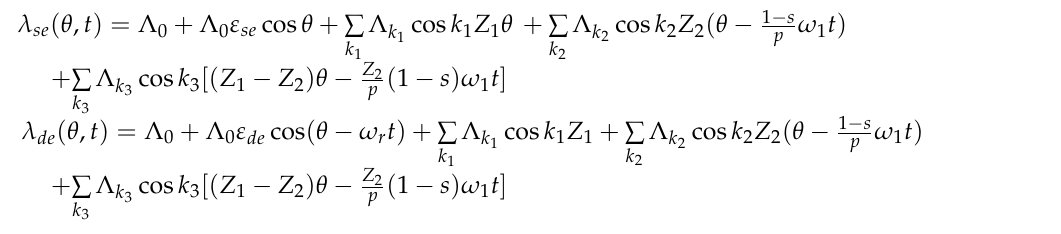
where Λ 0 is the mean air-gap permeance. Given the influence of stator and rotor slotting, the air-gap permeance will have a series of permeance harmonic components.